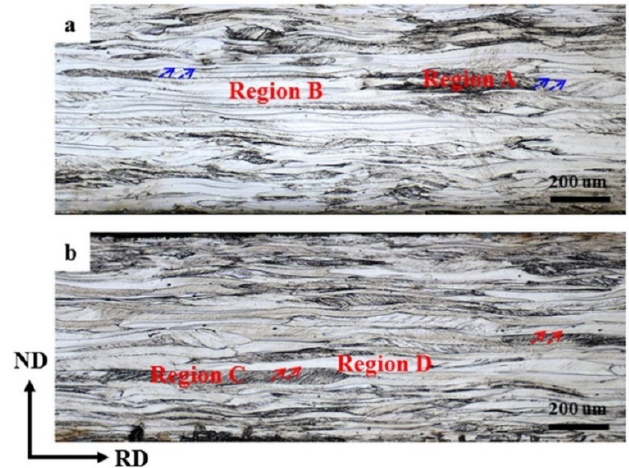
Figure 2. Optical microstructure of sample processed by ( a ) SR and ( b ) ASR. The arrows indicate the shear bands in the samples.